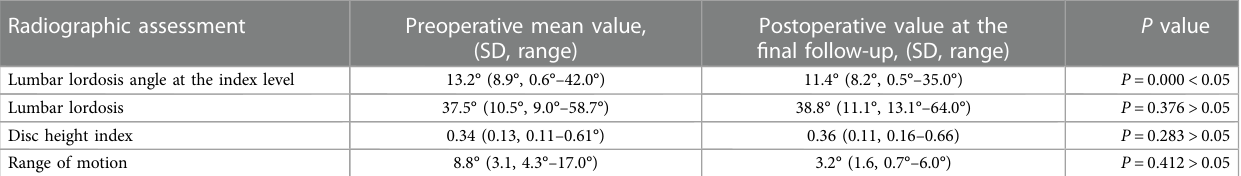
TABLE 2 Radiographic